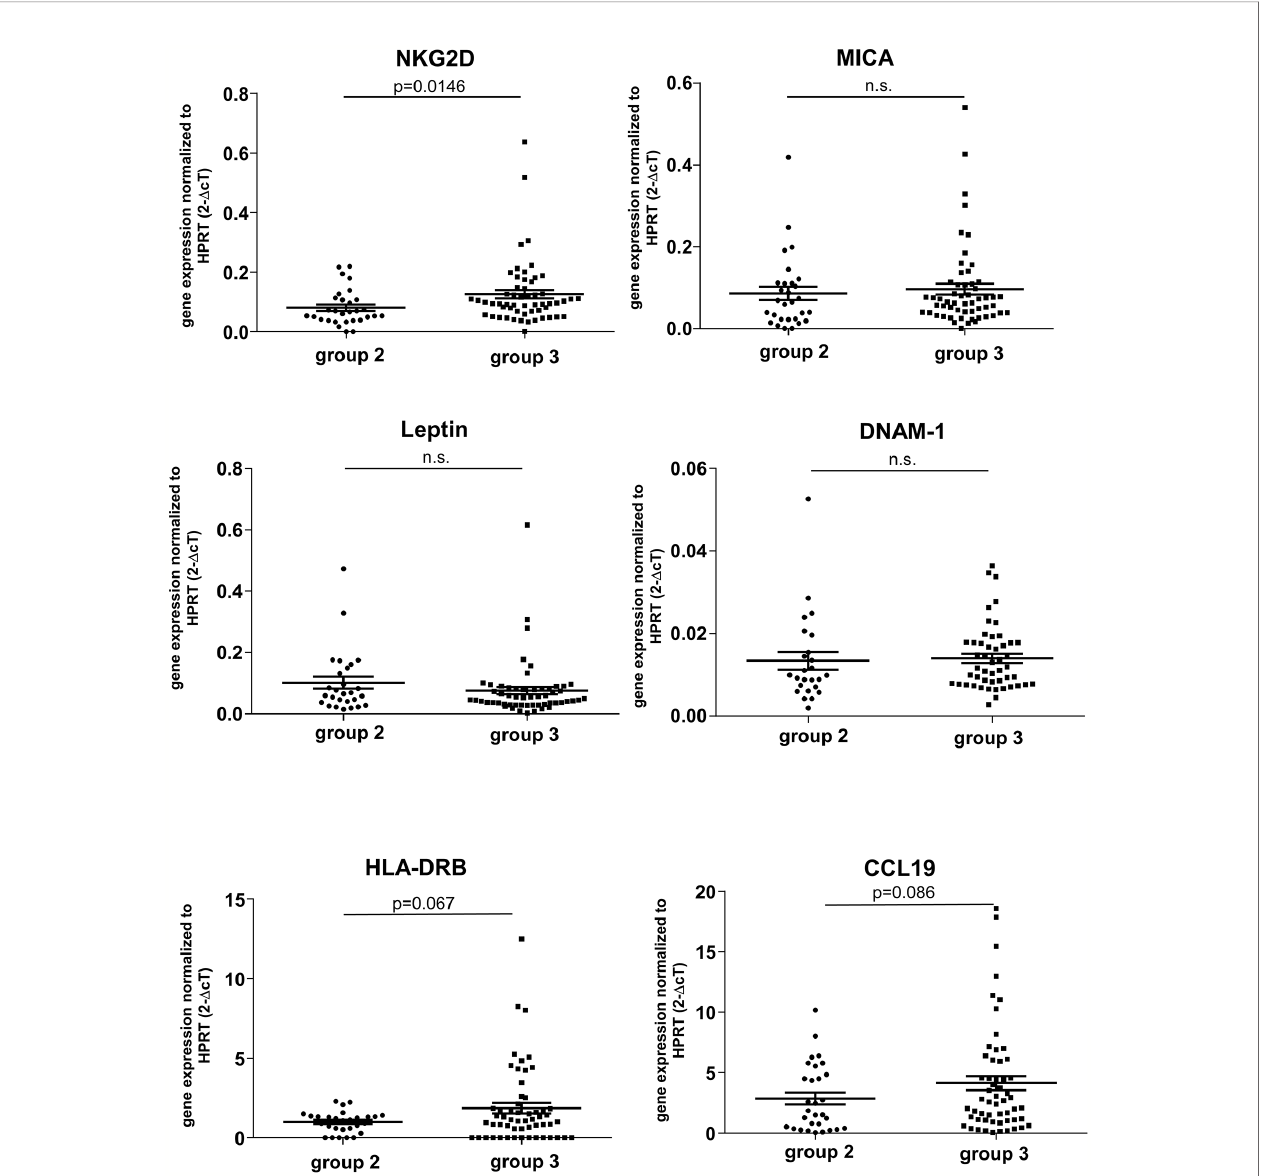
FIGURE 1 | mRNA expression of candidate genes in liver zero-hour biopsies according to donor BMI. Donor groups were de fi ned as summarized in Supplemental Table 2 . Gene expression was measured by real-time RT-PCR for the cytotoxicity receptor NKG2D and its ligand MICA, the adipokine leptin, the activating receptor DNAM-1, HLA-DRB and the chemokine CCL19. With the exception NKG2D all markers investigated did not demonstrate an elevated gene expression level in liver grafts derived from overweight and obese donors (Group 3, BMI: 25-29.9 kg/m²) compared with normal weight donors (Group 2, BMI: 18.5-24.9 kg/m²). Data of evaluable values are presented as mean values ± SEM. Statistically signi fi cant differences between normal and overweight donors were tested with two-sided Student ’ s T test. n.s., not signi fi